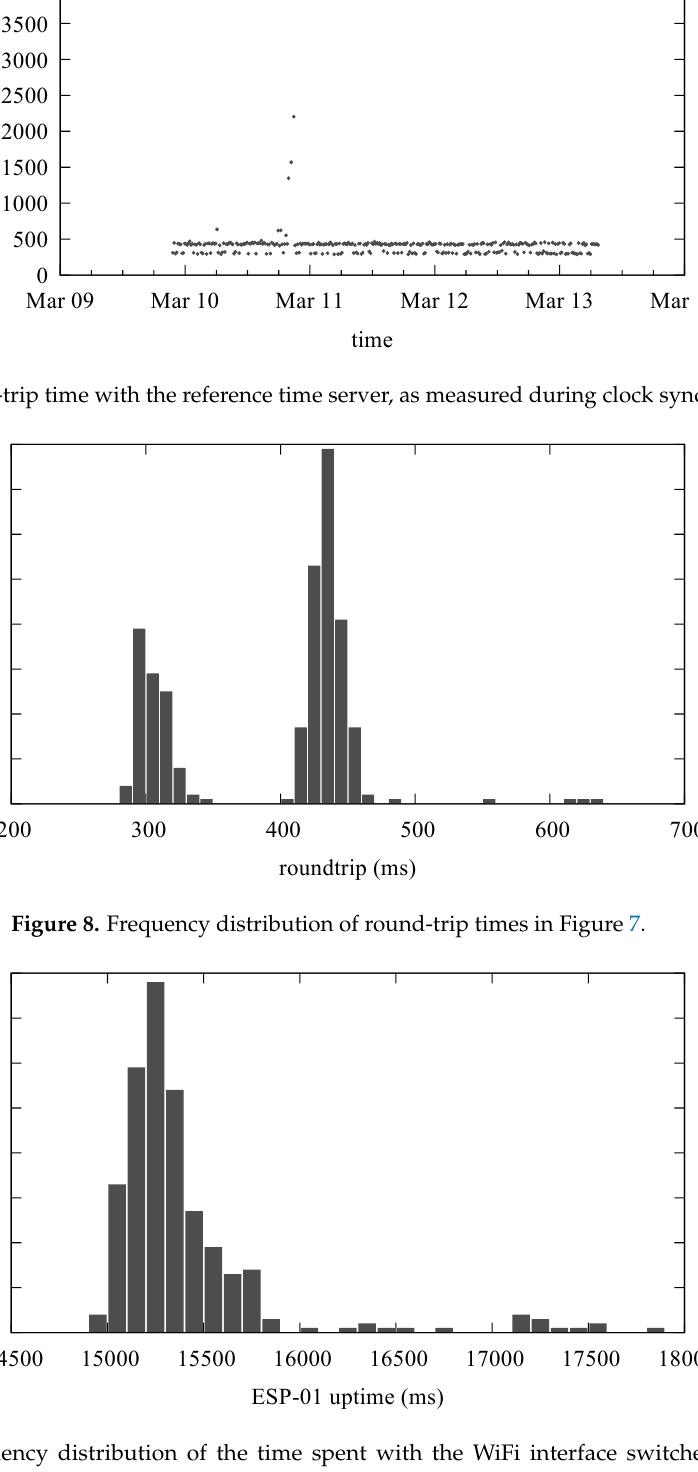
Figure 9. Frequency distribution of the time spent with the WiFi interface switched on during each